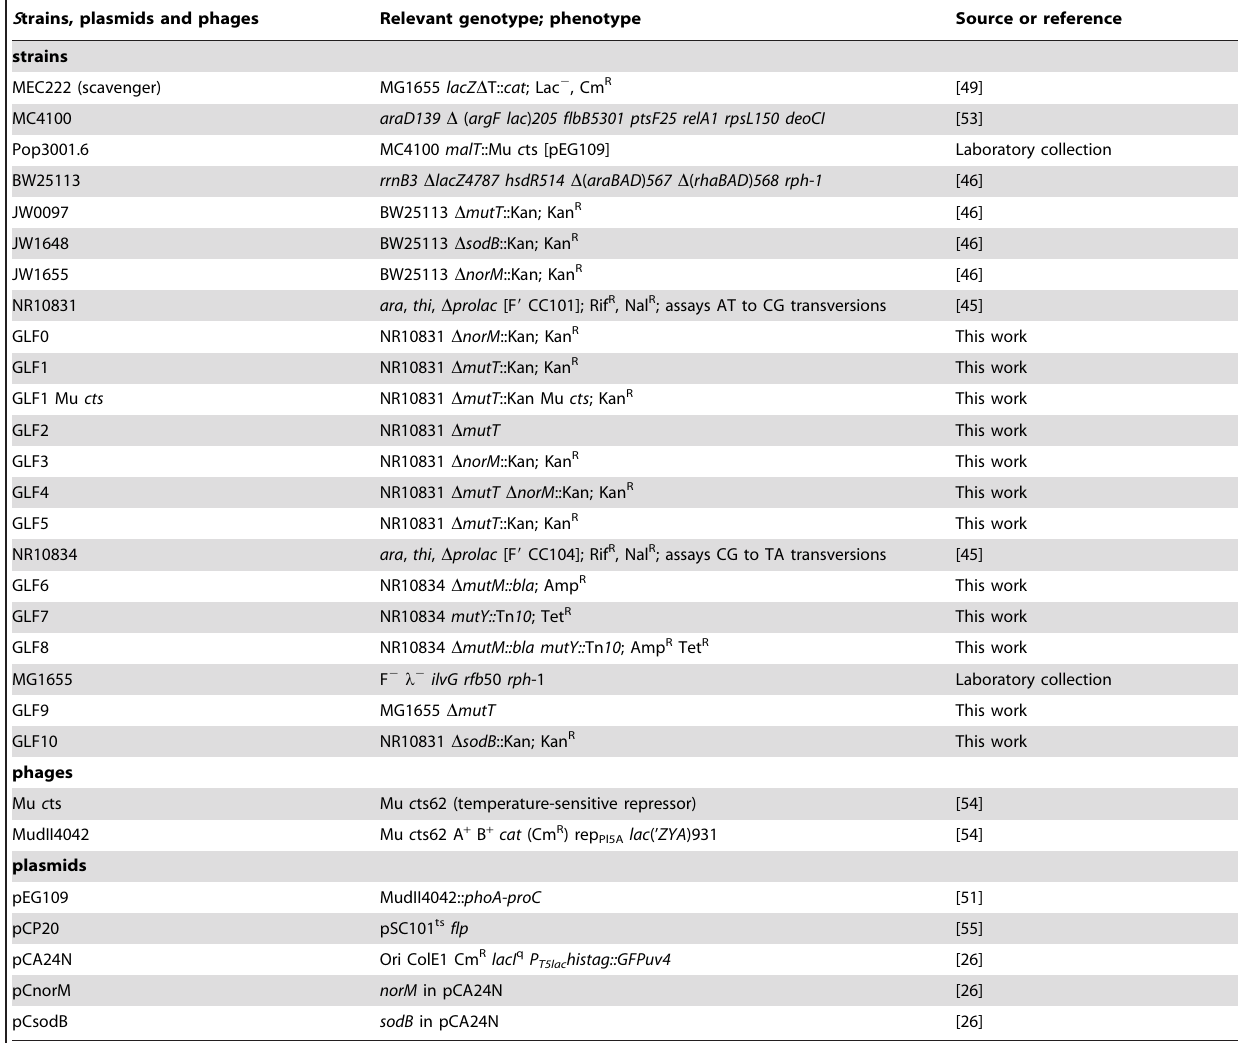
S trains, plasmids and phages Relevant genotype;